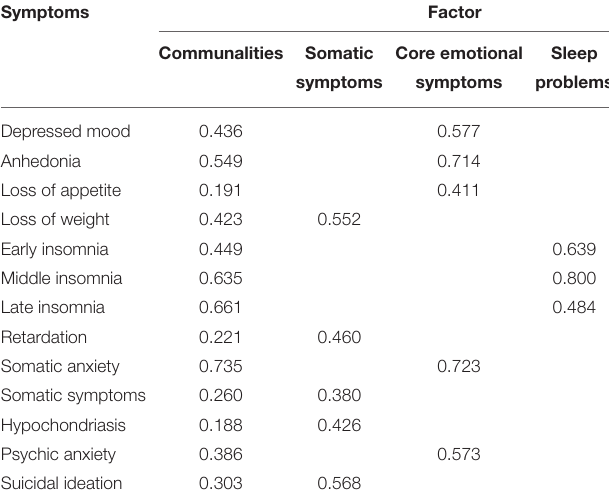
TABLE 2 | Communalities and factor loadings for HDRS scale.